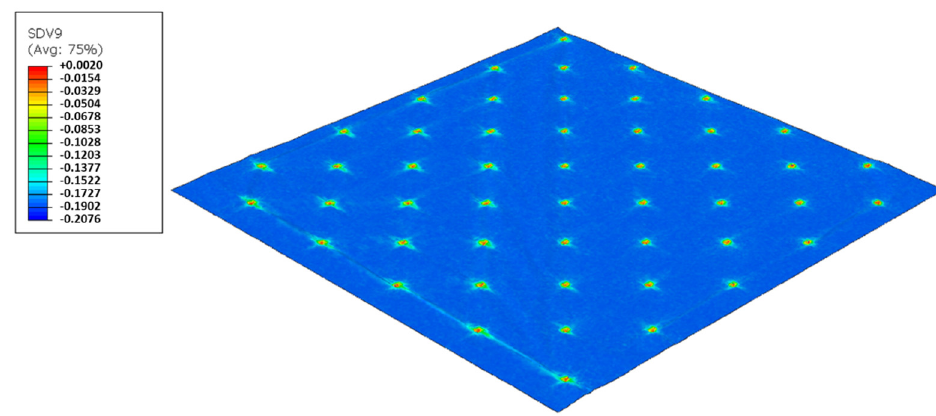
Figure 20. Micro die 75 Sh-A (CR PR), Plastic field.